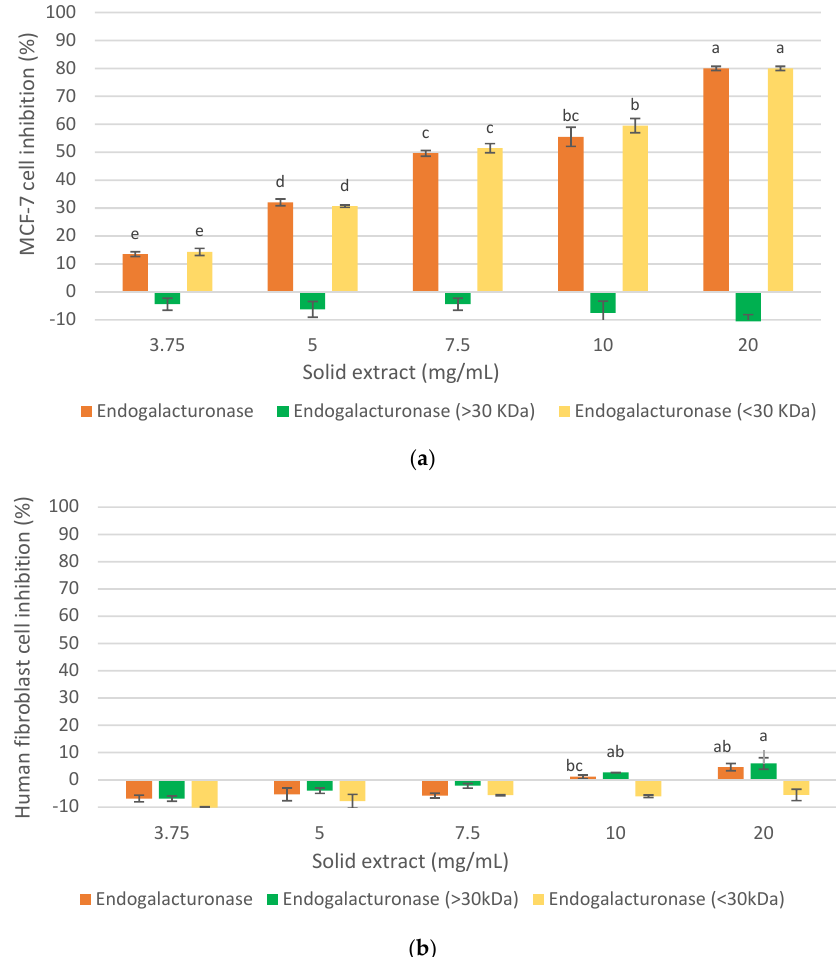
Figure 5. Effect of molecular weight of the fractions obtained from the oligosaccharide extract by ultrafiltration, on the cellular inhibition. ( a ) on MCF-7 cancer cell line, ( b ) on healthy human fibroblast cell. Mean ± SD ( n = 3). The median that does not share a letter are significantly different ( p > 0.05), comparing all values together with ANOVA and Tukey’s test.